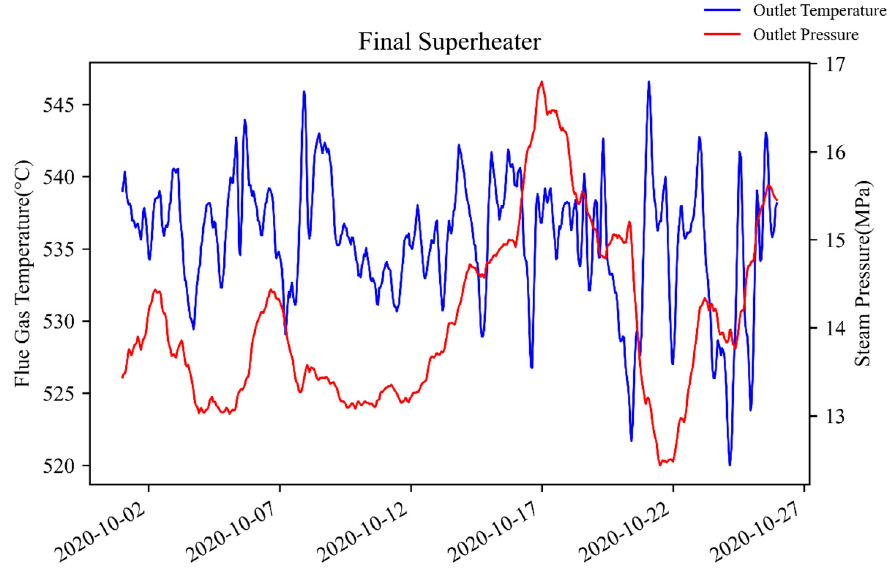
Figure 1. DCS system collects temperature and pressure data from the final superheater outlet.